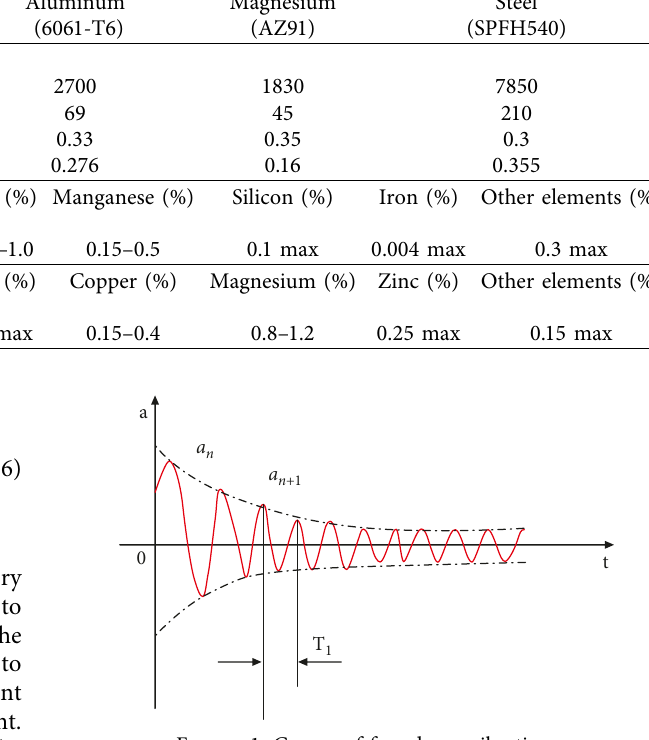
Figure 1: Curves of free decay vibration.